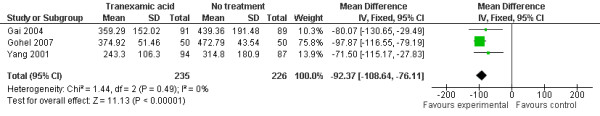
Meta-analysis comparing tranexamic acid with no treatment. Mean blood loss up to two hours after delivery, expressed in millilitres.